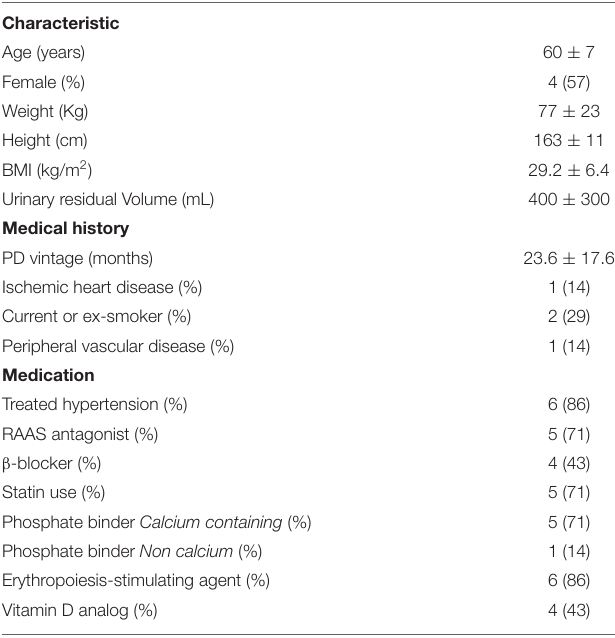
TABLE 2 | Bloodwork collections before and after peritoneal dialysis PD for normothermic (NT) and therapeutic hypothermia (TH) conditions. Characteristic